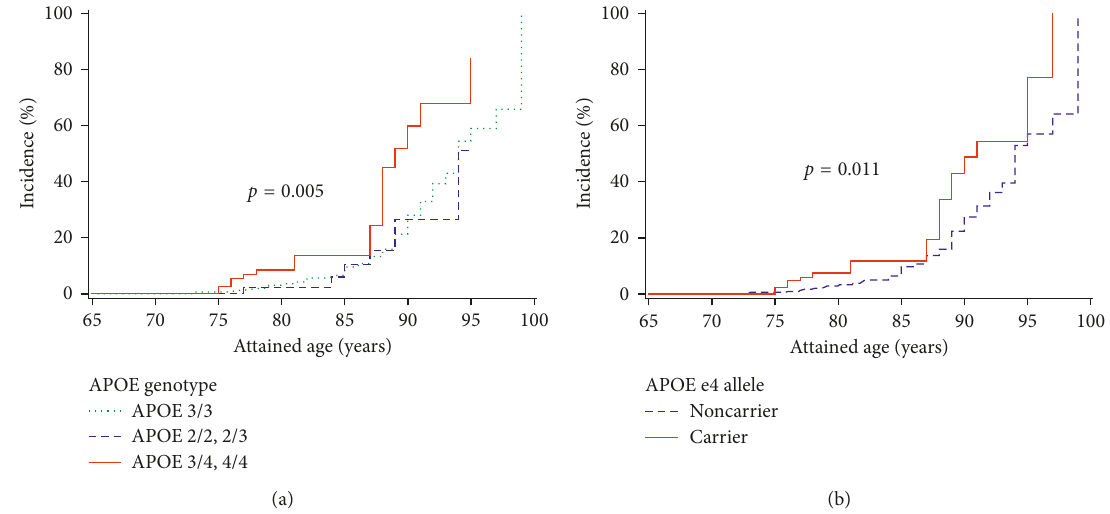
Figure 1: Kaplan–Meier cumulative incidence estimates for all-cause mortality by (a) APOE genotype and (b) APOE ε 4 allele. Table 2: APOE genotype and allele as predictors of all-cause mortality. Unadjusted Model